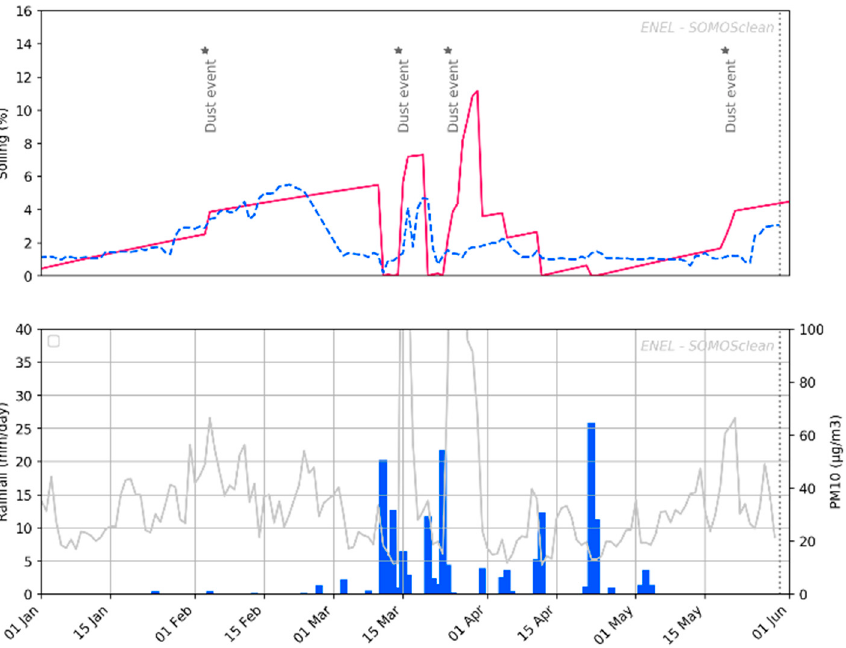
Figure 6. Upper plot: Soiling model (magenta line) and soiling sensor output (dashed blue line). Lower plot: Rainfall (mm/day) and PM10 concentration (µg/m 3 ).